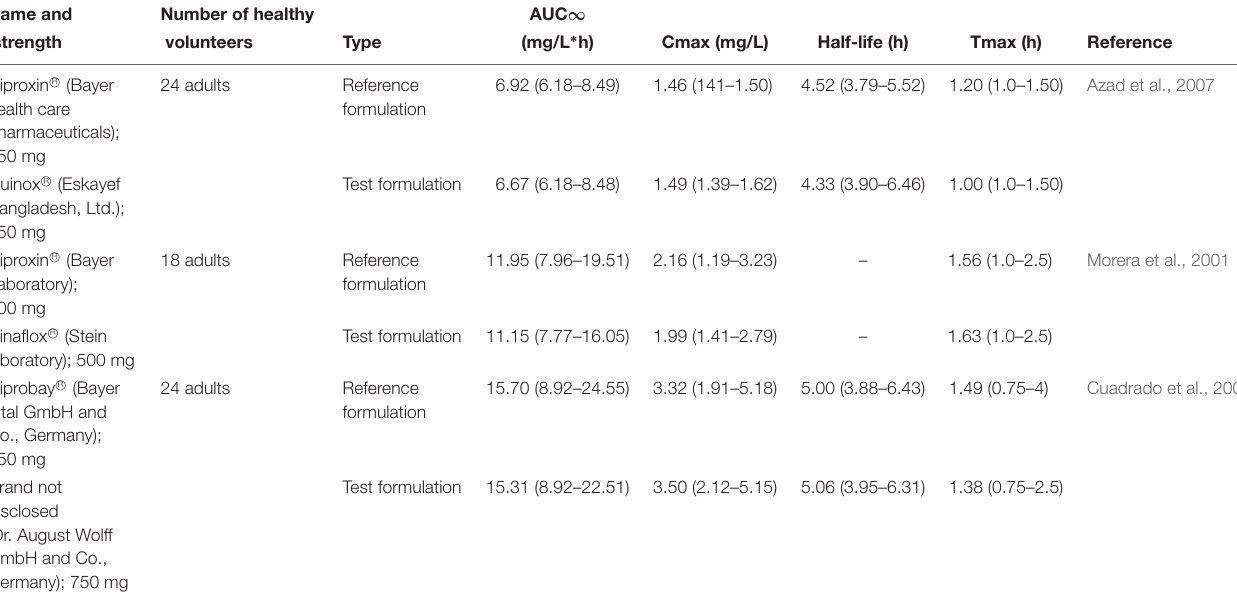
TABLE 1 | Mean (range) pharmacokinetic parameters from a single dose of reference and test tablets of